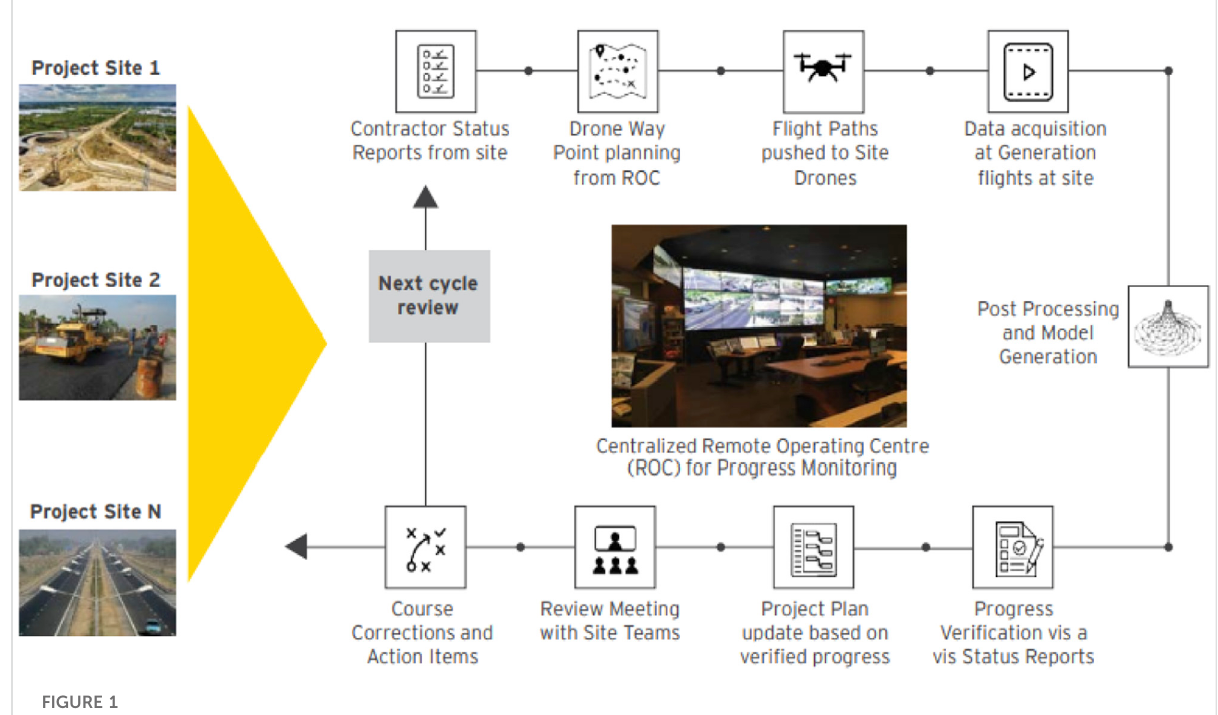
FIGURE 1 Schematic of a remote operating command center (Ficci,